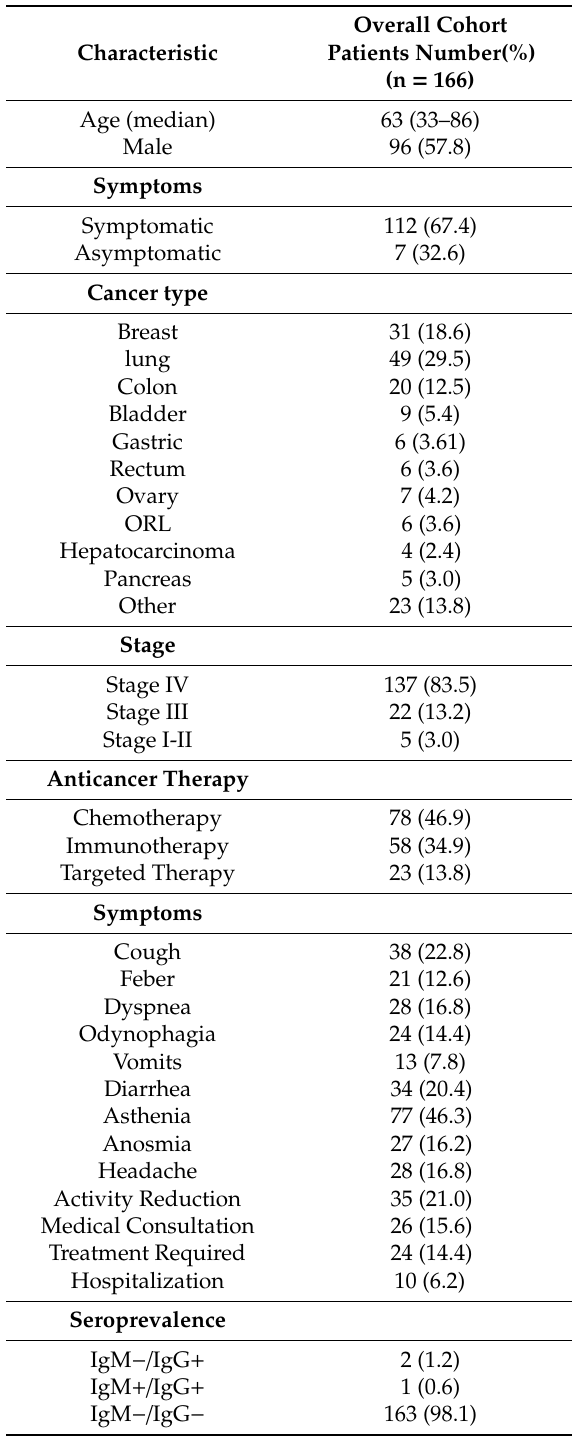
Table 2. Demographic, clinical characteristic and seroprevalence of COVID-19 in patients receiving anticancer treatment. Cohort